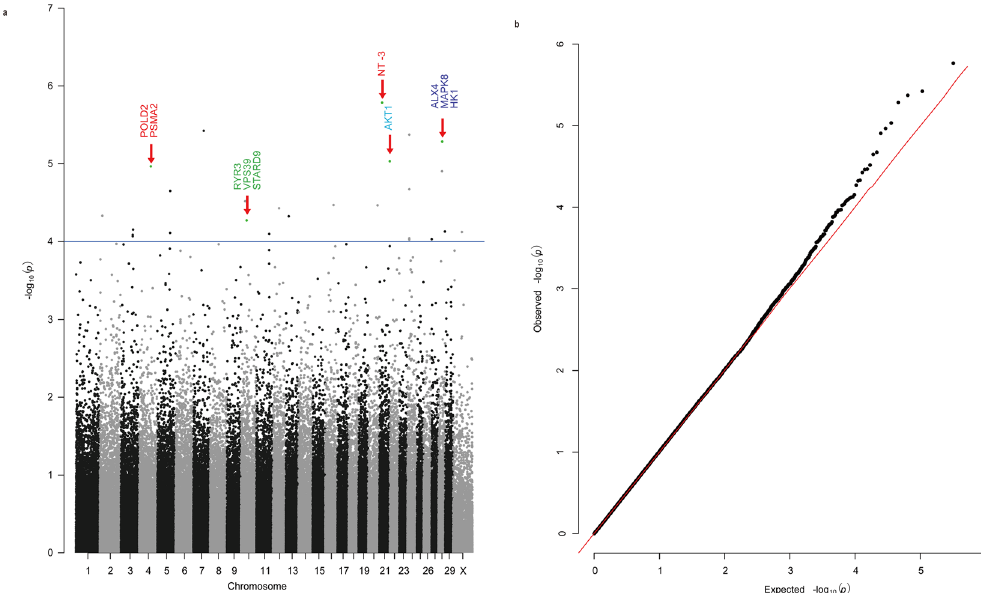
Figure 8. Manhattan and quantile-quantile plot of GWAS for fiber fineness in cashmere goat. ( a ) Manhattan plot of the compressed MLM model for fiber fineness. ( b ) Quantile-quantile plot of the compressed MLM model for fiber fineness.